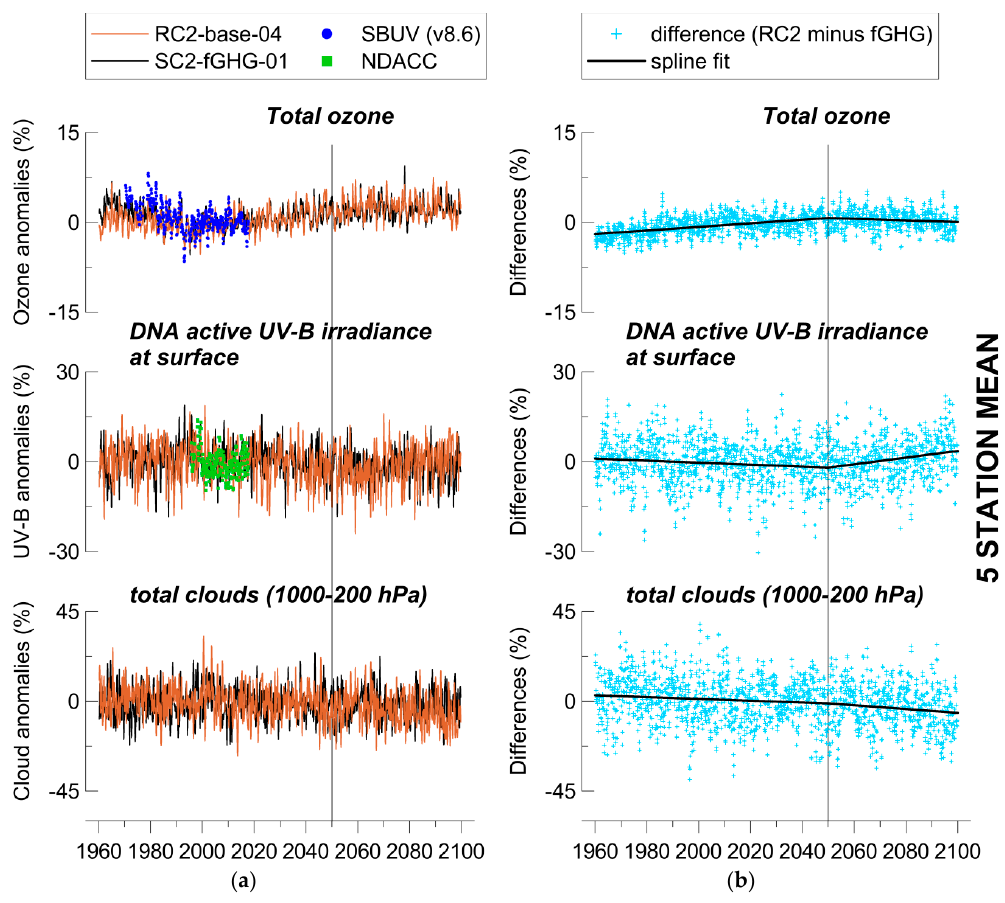
Figure 6. ( a ) Impact of GHGs on total ozone, UV-B irradiance and clouds based on simulations with increasing and fixed GHGs mixing ratios. RC2-base-04 is the simulation with increasing GHGs according to RCP-6.0; SC2-fGHG-01 is the simulation with fixed GHGs emissions at 1960 levels. The anomalies are deseasonalized data averaged at five lidar stations (HHP–OHP–TMO–MLO–LAU). Green dots show deseasonalized DNA-weighted UV data averaged at OHP, MLO and LAU from the Network for the Detection of Atmospheric Composition Change (NDACC). (b) Difference between the two model simulations.